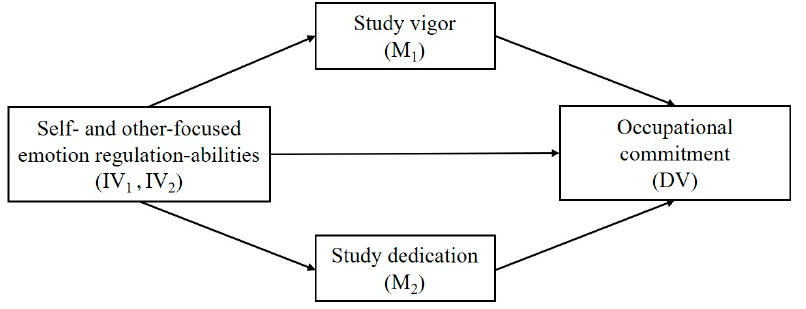
Figure 1. The proposed conceptual model.